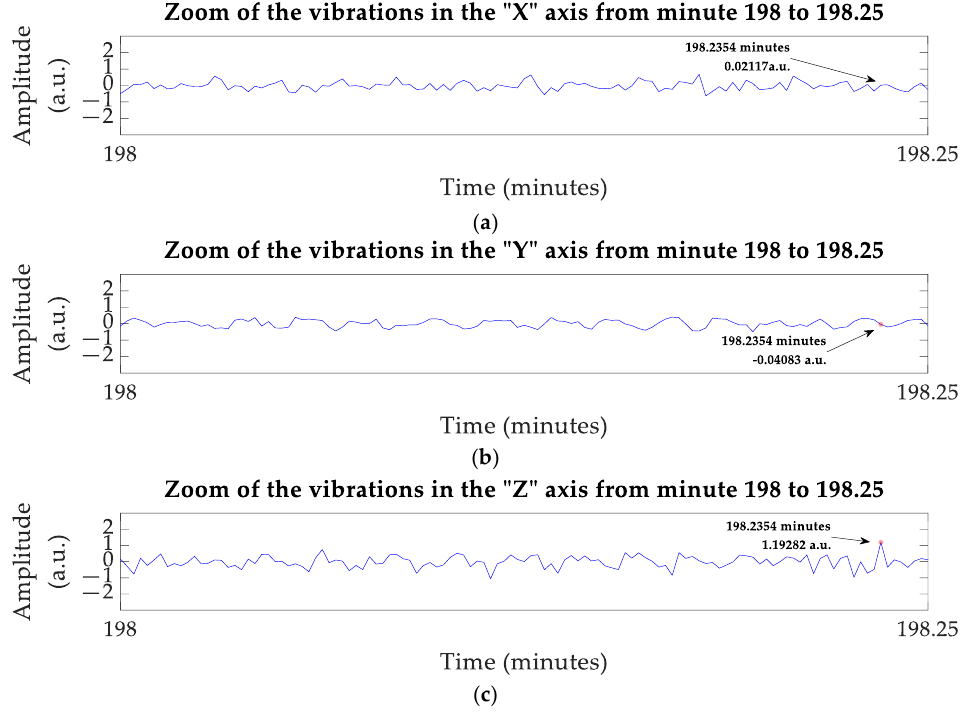
Energies 2023 , 16 , x FOR PEER REVIEW Figure 9. ( a ) Shows a zoom from minute 188 to minute 188.25 on the “X” axis, a.u (arbitrary units); Figure 9. ( a ) Shows a zoom from minute 188 to minute 188.25 on the “ X ” axis, a.u (arbitrary units); ( b ) Shows a zoom from minute 188 to minute 188.25 on the “Y” axis, a.u (arbitrary units); ( c ) Shows a ( b ) Shows a zoom from minute 188 to minute 188.25 on the “ Y ” axis, a.u (arbitrary units); ( c ) Shows zoom from minute 188 to minute 188.25 on the “Z” axis, a.u (arbitrary units). a zoom from minute 188 to minute 188.25 on the “ Z ” axis, a.u (arbitrary units).